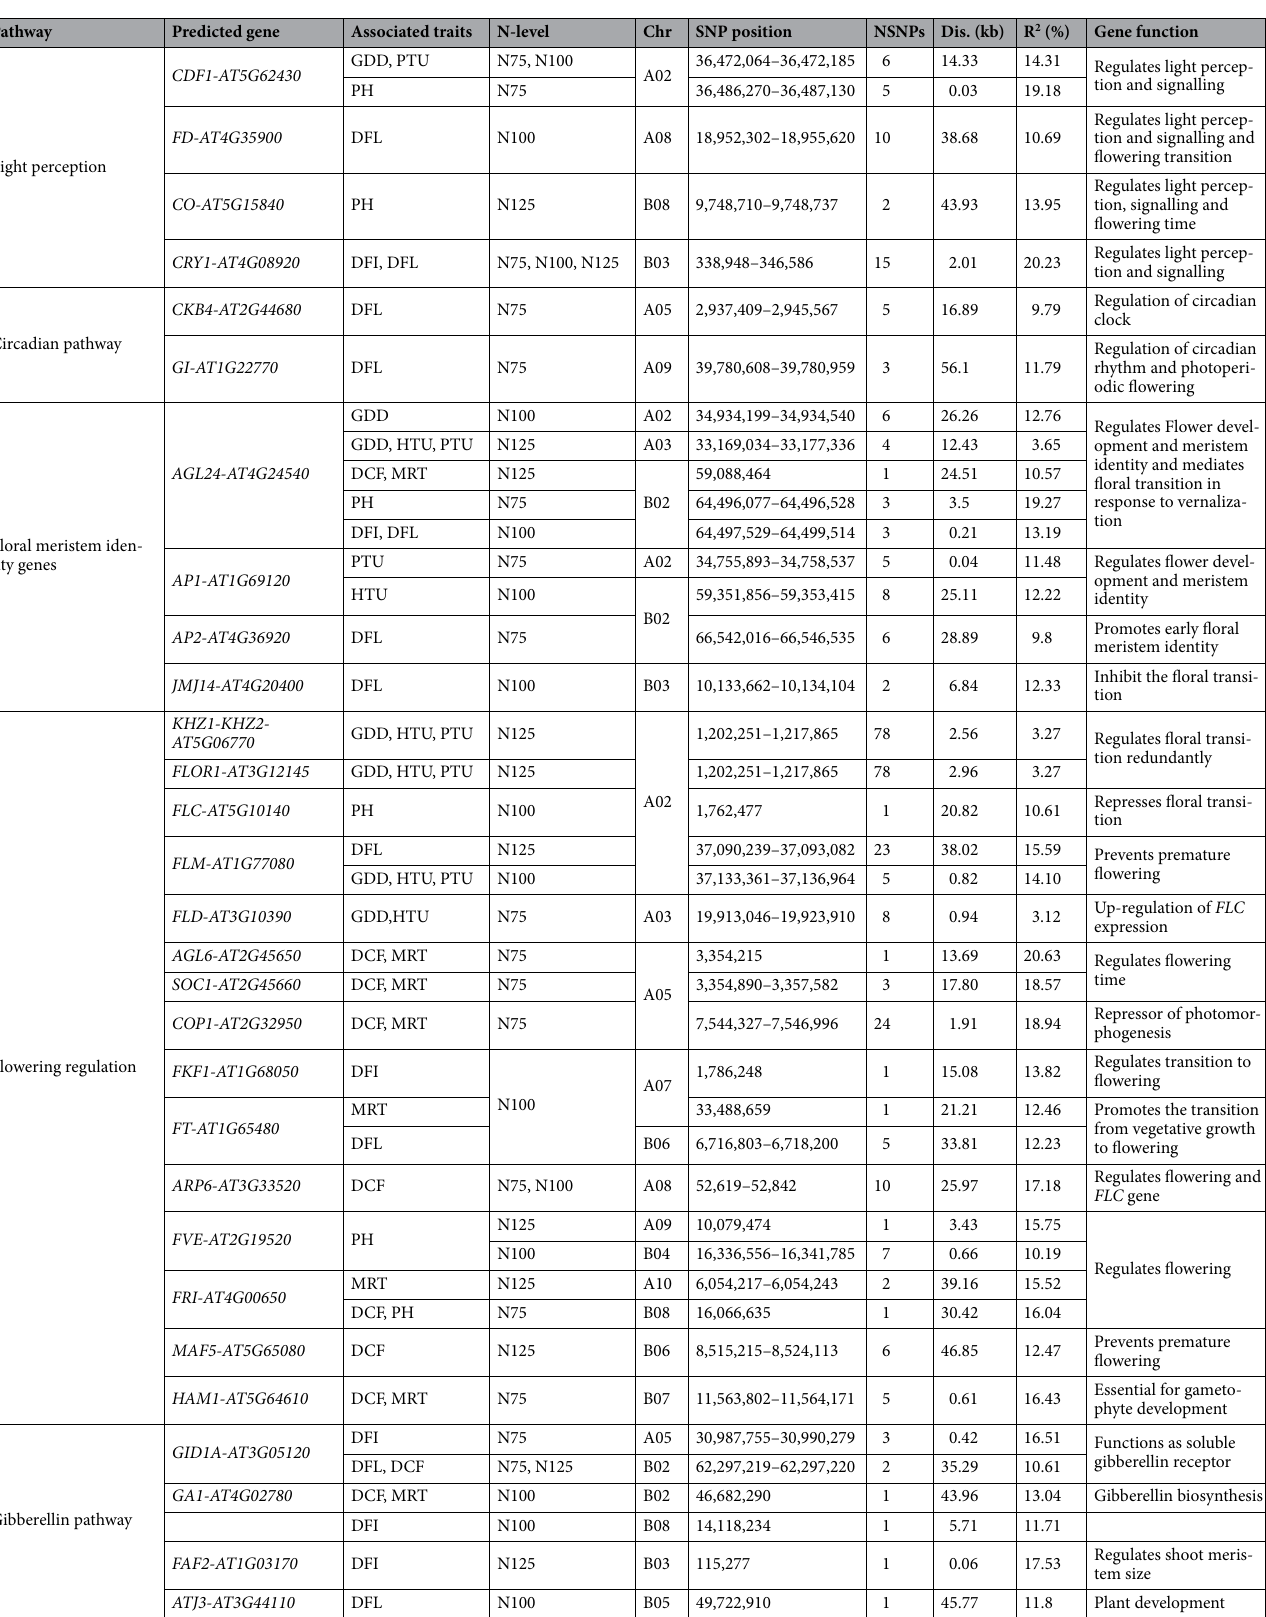
Table 2. Genome wide association studies to predict candidate genes associated with flowering, maturity and plant height. Chr chromosome, NSNPs number of associated significant SNPs, Dis. (kb) distance of annotated gene from nearest significant associated SNPs with the trait, R 2 phenotypic variation explained in